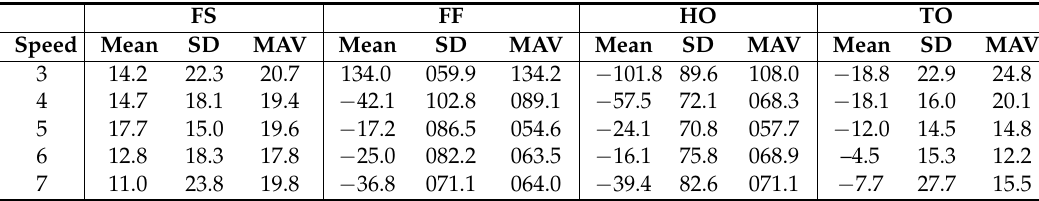
Table 3. Gait events statistics, in ms (difference between HMM-based and reference data). FS FF HO TO Speed